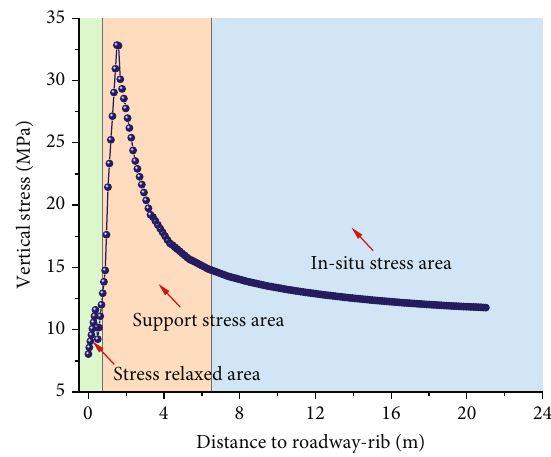
Figure 8: Relations between vertical stress and the distance from the rib of roadway.